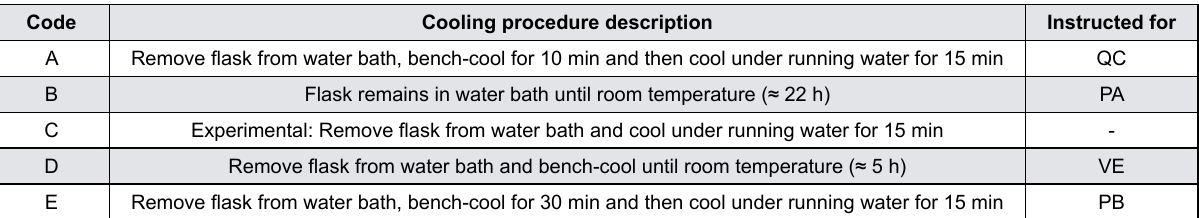
Figure 1- The heat-cured denture base materials used in the